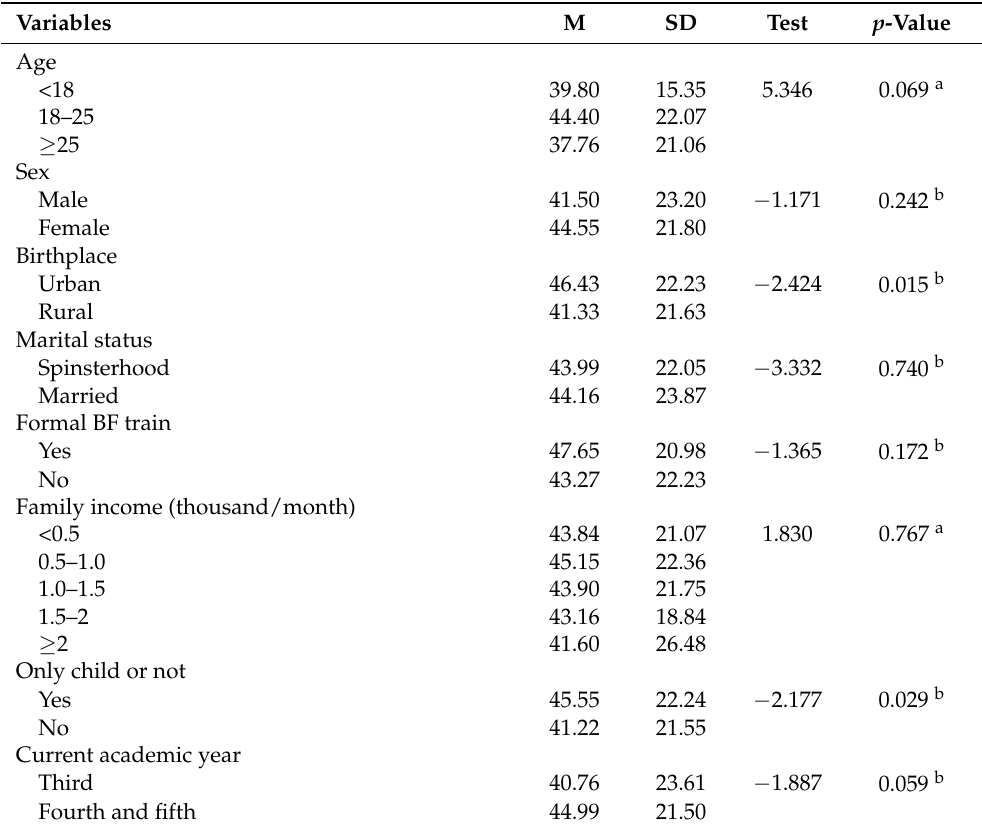
Table 3. The results of univariate analysis on the influencing factors of breastfeeding knowledge ( n =